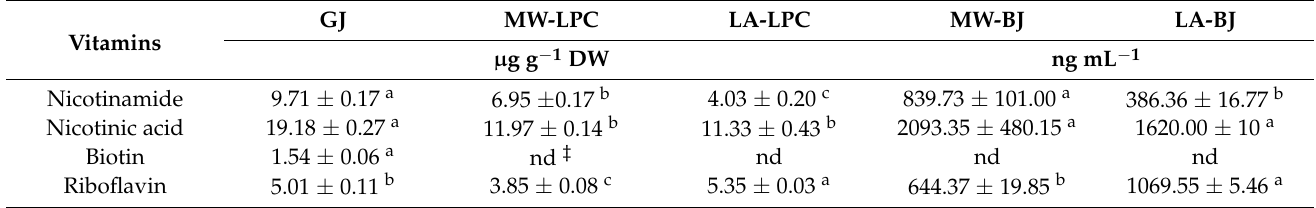
Table 3. Quantitative alterations of vitamins in broccoli green leaves-derived products by different fractionation processes ( Process 1; Process2 and Process 3 ): freeze-dried green juice (GJ); leaf protein concentrate obtained by microwave coagulation (MW-LPC); leaf protein concentrate obtained by lactic acid fermentation (LA-LPC); brown juice obtained by microwave coagulation (MW-BJ); and brown juice obtained by lacto-fermentation